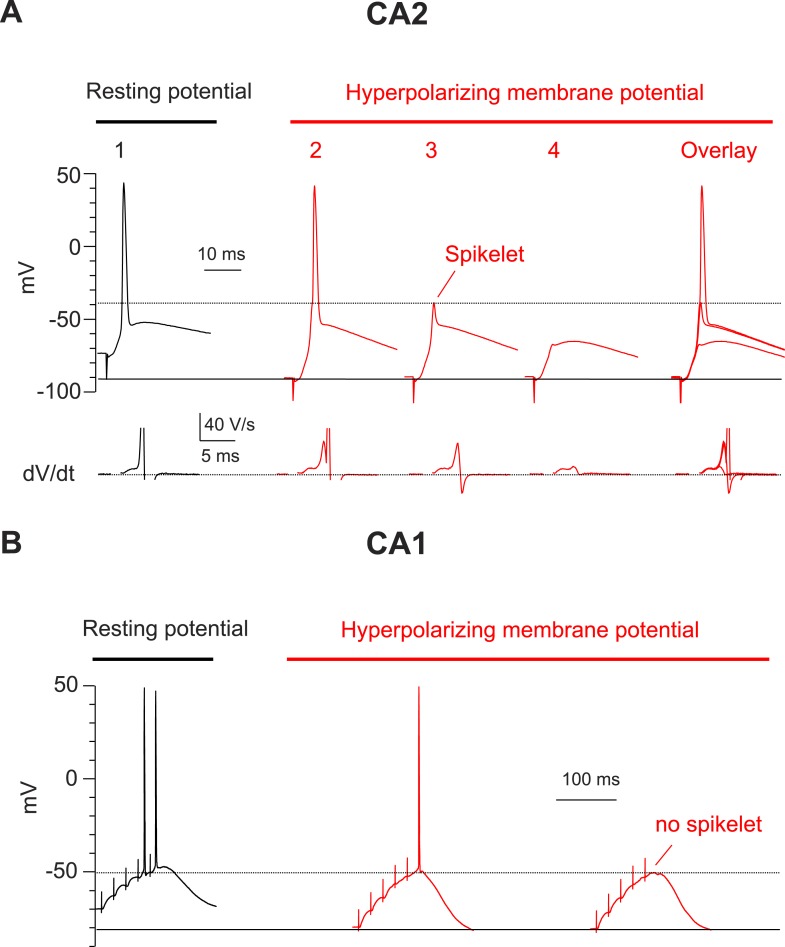
Hyperpolarization of membrane potential reveals prominent spikelets at the soma of CA2, but not CA1, PNs in response to PP stimulation.(A) Top: a PP stimulus in a CA2 PN reliably elicited a somatic AP at the normal resting potential (trace 1). Hyperpolarization of the resting membrane (traces 2–4) reveals that a PP stimulus with constant strength induced spikelets that variably succeeded (trace 2) or failed (trace 3) in triggering a somatic AP from the hyperpolarized potential. Trace 4 shows a very weak spikelet response to the PP stimulus. Bottom: dV/dt for corresponding voltage responses on top. dV/dt of APs is truncated. Right: overlay of traces 2–4. (B) High-frequency burst PP stimulation (50 Hz, 5 pulses) in a CA1 PN triggers somatic APs at the resting potential (left). Hyperpolarization of the resting membrane fails to reveal spikelets (right).